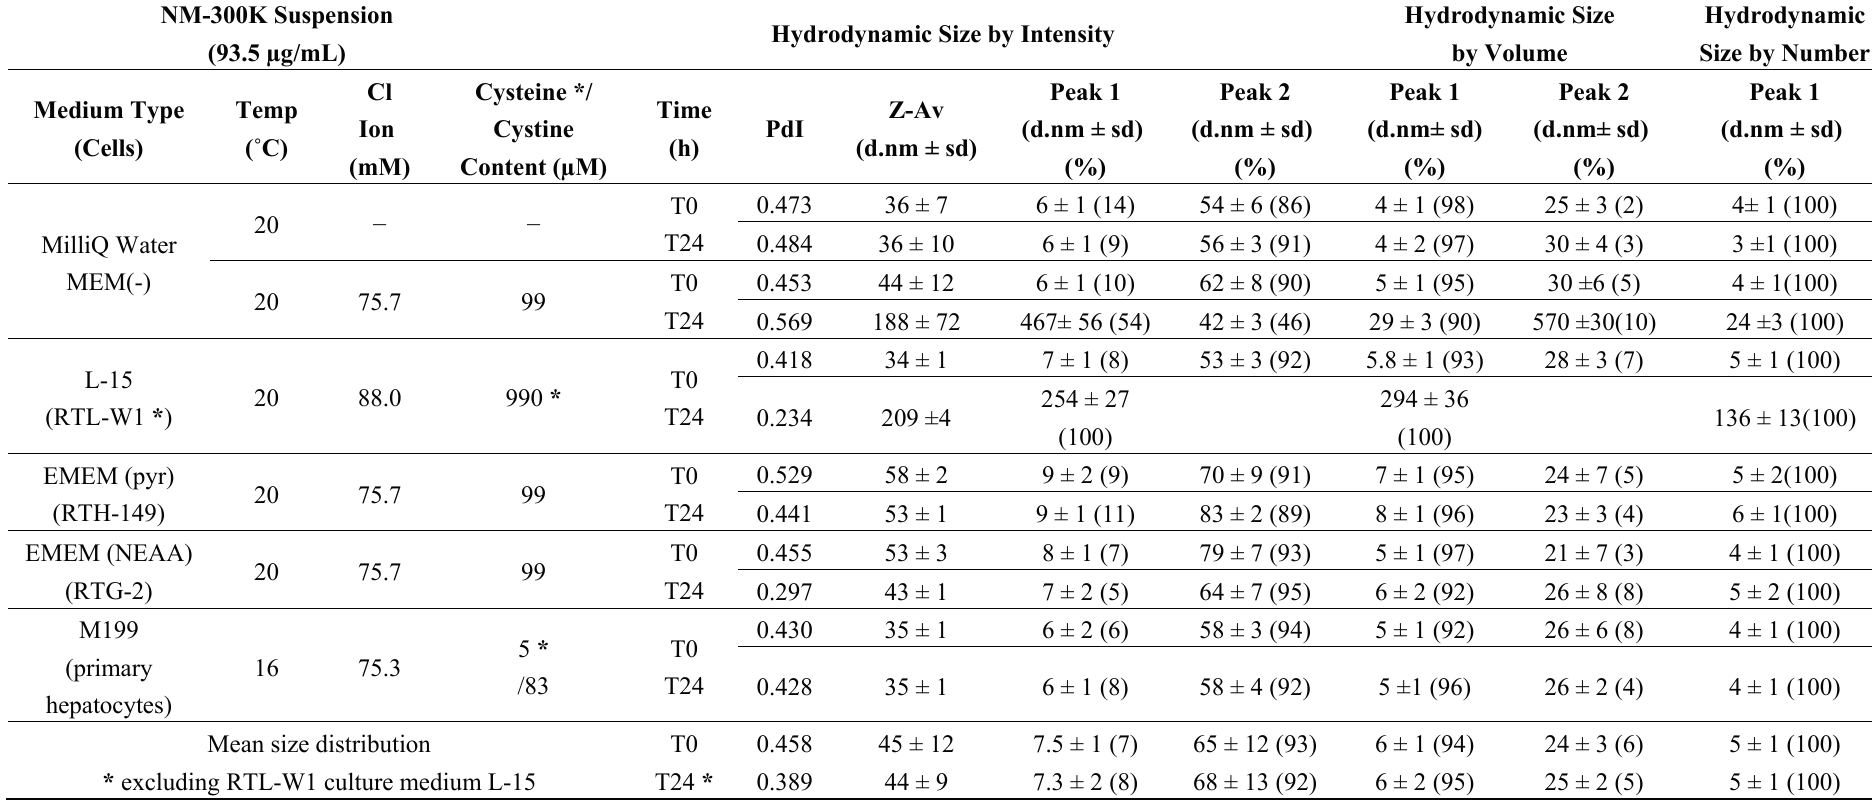
Table 1. Size distribution of the NM-300K dispersion in the various culture medium suspensions used in exposure studies characterised by dynamic light scattering (size distribution by intensity, volume and